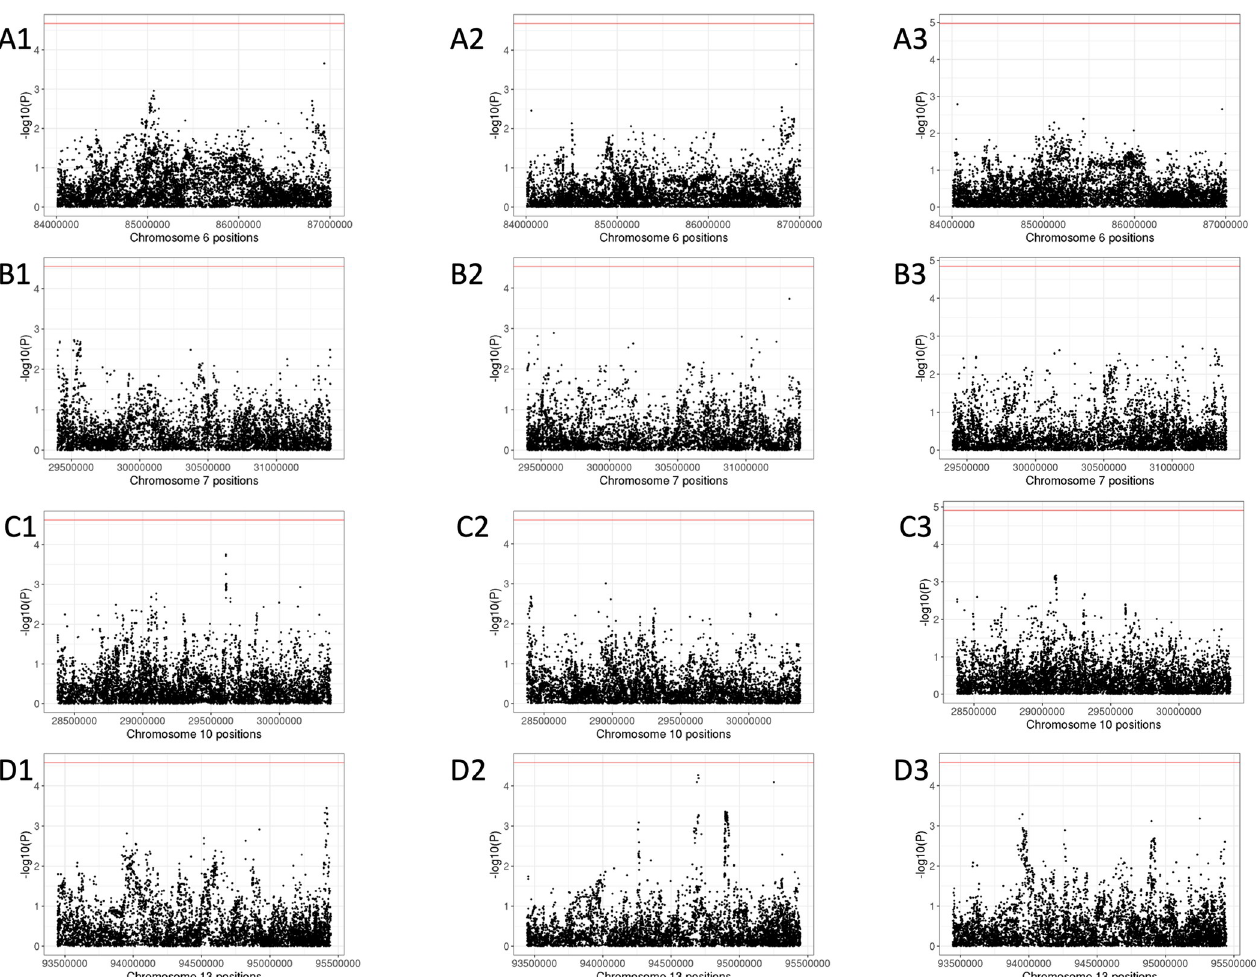
Fig 5. Case-control association analyses between SNPs and pilocytic astrocytoma risk of CCRLP Latino, European subjects and meta-analysis of both results in regions of admixture mapping peaks A1, fine mapping of the 3 Mb region of chromosome 6 admixture mapping peak in CCRLP Latino subjects. A2 , fine mapping of the 3 Mb region of chromosome 6 admixture mapping peak in CCRLP European subjects. A3 , meta-analysis of results from A1 and A2. B1 , fine mapping of the 2 Mb region of chromosome 7 admixture mapping peak in CCRLP Latino subjects. B2 , fine mapping of the 2 Mb region of chromosome 7 admixture mapping peak in CCRLP European subjects. B3 , meta-analysis of results from B1 and B2. C1 , fine mapping of the 2 Mb region of chromosome 10 admixture mapping peak in CCRLP Latino subjects. C2 , fine mapping of the 2 Mb region of chromosome 10 admixture mapping peak in CCRLP European subjects. C3, meta-analysis of results from C1 and C2. D1 , fine mapping of the 2 Mb region of chromosome 13 admixture mapping peak in CCRLP Latino subjects. D2 , fine mapping of the 2 Mb region of chromosome 13 admixture mapping peak in CCRLP European subjects. D3 , meta-analysis of results from D1 and